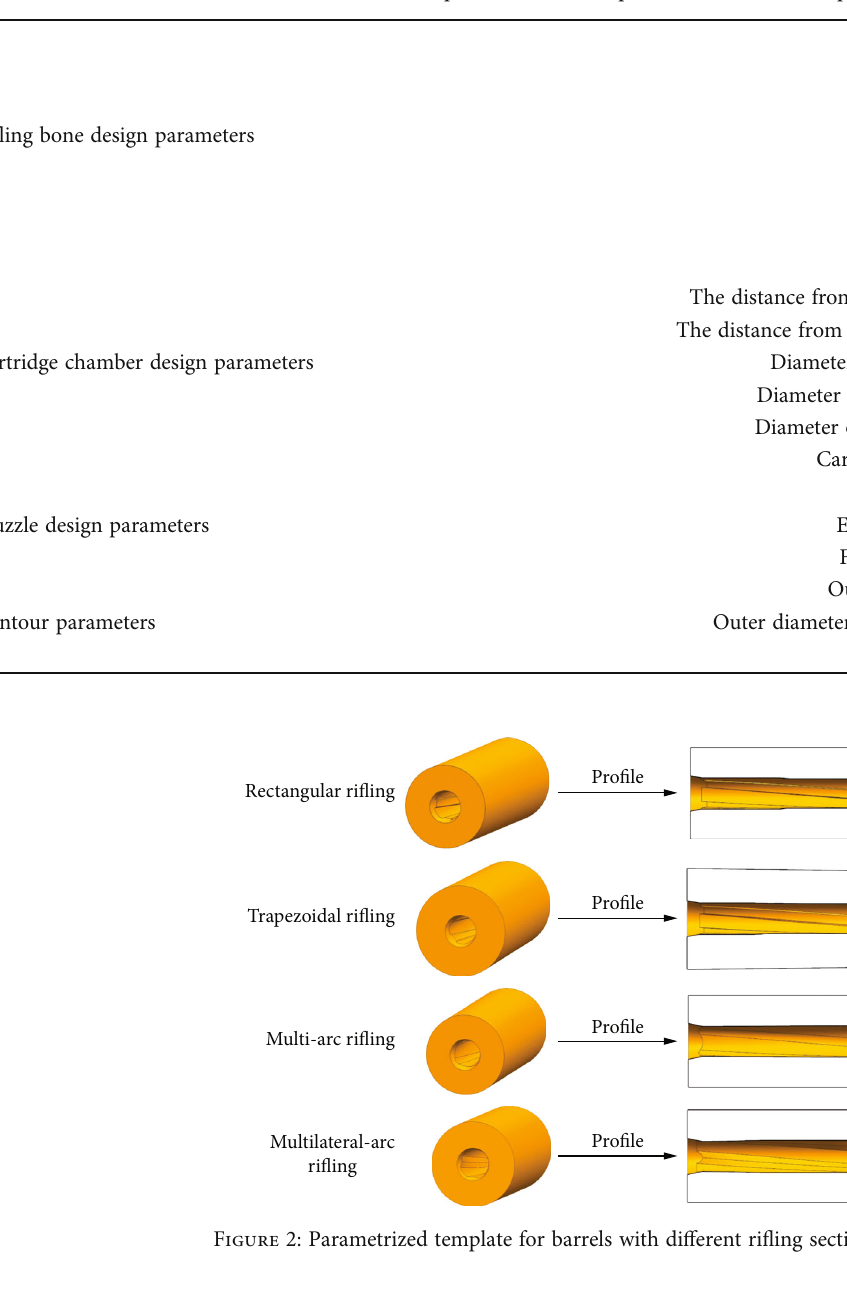
Table 1: Drive parameters for the parametrized barrel template.